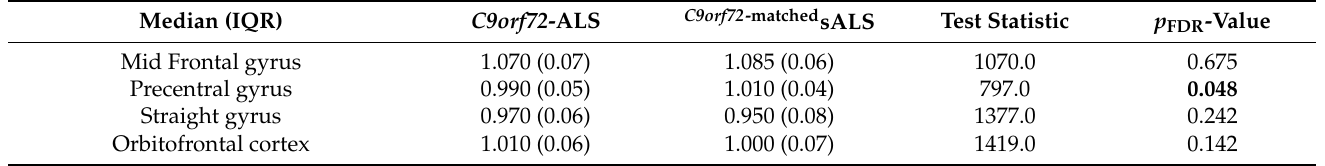
Table 3. Volume-of-interest (VOI)-based Mann–Whitney U test of 18F-FDG SUVR between C9orf72 - ALS (n = 48) patients and matched sporadic ALS ( C9orf72 -matched sALS; n = 48) patients. Significant p - values, after applying FDR correction ( α FDR = 0.05), are shown in bold. Abbreviations: C9orf72-ALS, C9orf72-associated ALS; IQR, interquartile range; Md, median; sALS = sporadic ALS; SUVR = standardized uptake value ratio.